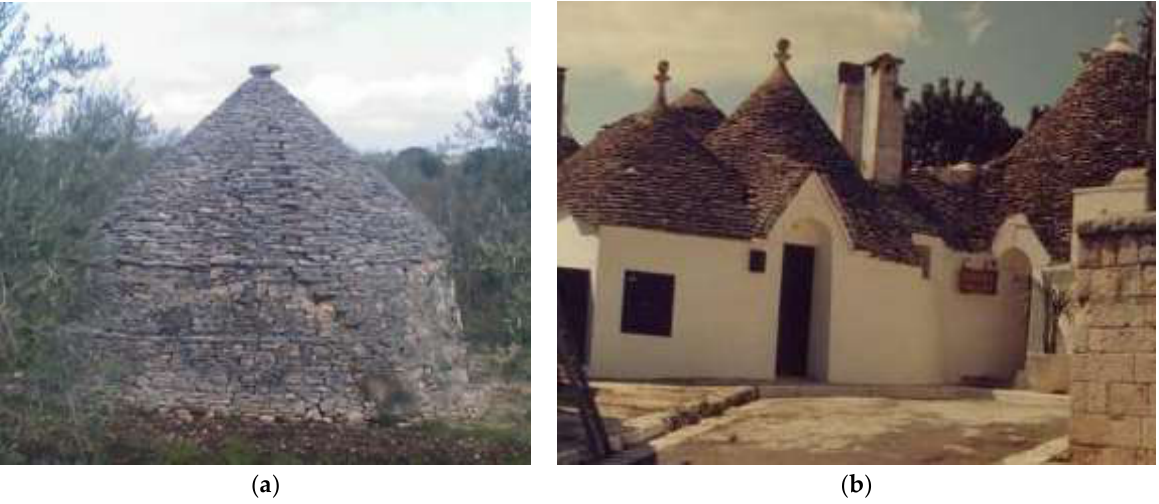
Figure 7. ( a ) A mono-cell rural trullo, with steps on the roof and ( b ) some city